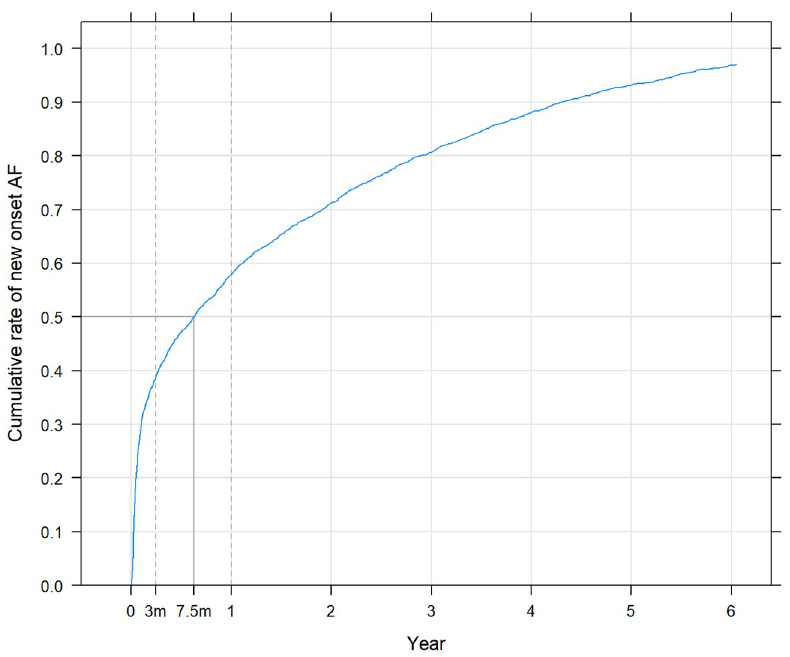
Fig 2. The time from discharge from valve intervention to diagnosis of new-onset atrial fibrillation. The dotted line indicate the three months period after valve intervention.